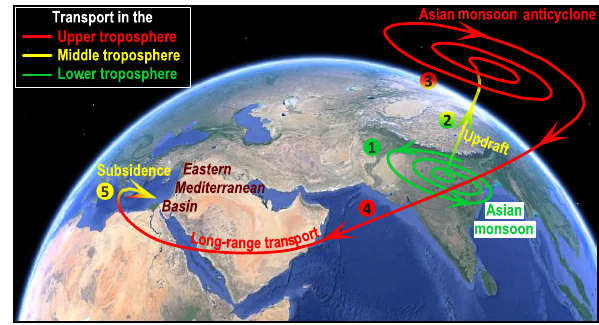
Figure 27. Schematic representation of the processes impacting the mid-to-upper tropospheric pollutants, including CH 4 above the eastern Mediterranean in summer (July–August) (adapted from Ri- caud et al.,